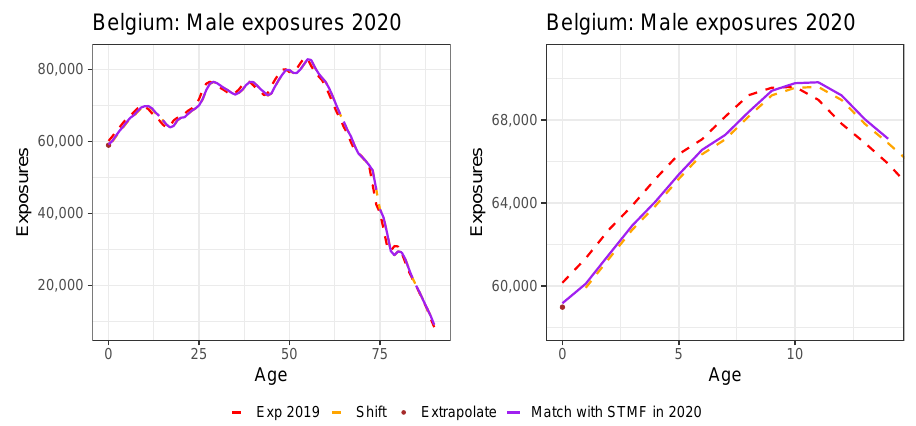
Figure A2. The virtual exposure E x , t for Belgium in the year 2020, for males. At the right, we show a snapshot for the age range